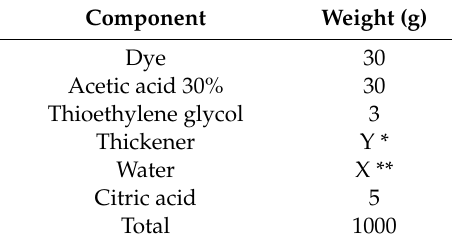
Table 2. Printing paste for basic dyestu ff